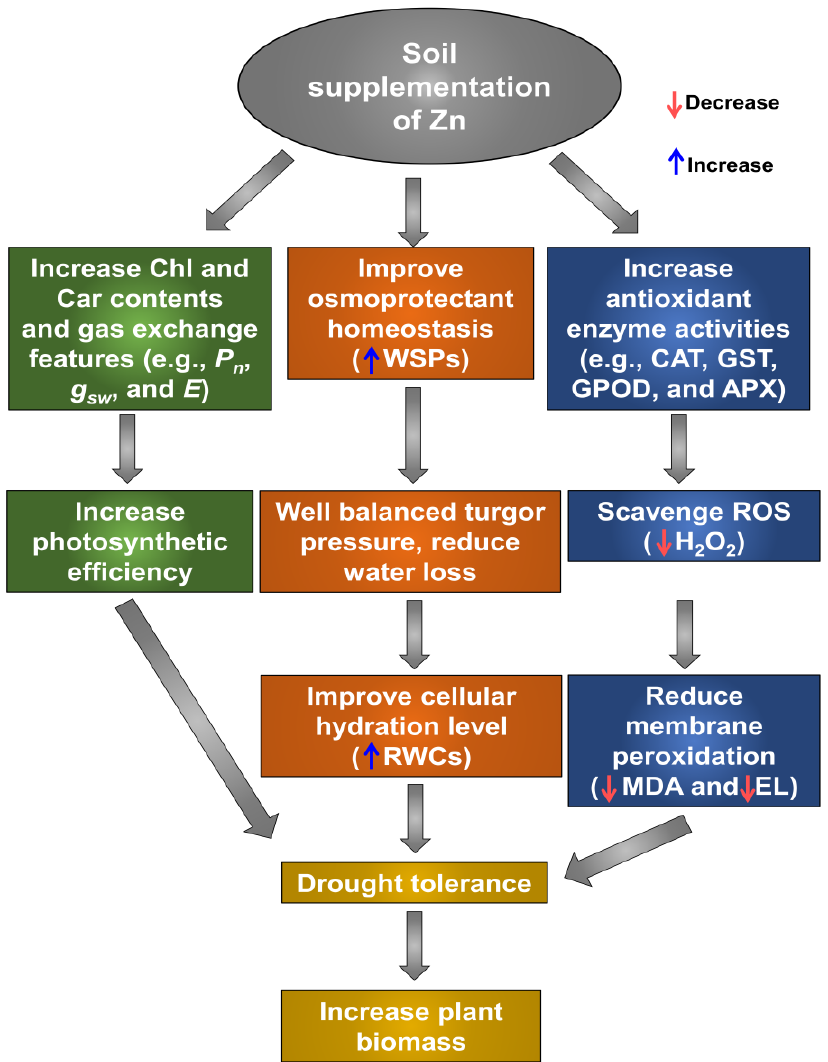
Figure 7. Function of zinc (Zn) in regulating cotton physiological and biochemical mechanisms to overcome drought-caused negative effects. Zn supplementation (either in the form of ZnSO 4 or ZnO) to drought-stressed cotton plants significantly decreased their growth penalty, partly by protecting photosynthetic pigments and improving gas exchange features, which finally enhanced the overall photosynthetic efficiency and growth performance. Zn addition also activated the antioxidant defense mechanism by increasing the activities of enzymatic antioxidants (e.g., CAT, GST, GPOD, and APX), which helped protect Zn-supplemented cotton plants against reactive oxygen species (ROS)-induced oxidative stress and membrane damage. Furthermore, through boosting water-soluble proteins (WSPs) content, Zn aided osmoprotection, which eventually helped preserve leaf water status for osmotic adjustment under water-scarce conditions. Blue arrow represents an upward trend, while red arrow denotes a declining trend. APX, ascorbate peroxidase; Cars, carotenoids; CAT, catalase; Chls, chlorophylls; E , transpiration rate; EL, electrolyte leakage; GST, glutathione S -transferase; GPOD, guaiacol peroxidase; g sw , stomatal conductance to H 2 O; H 2 O 2 , hydrogen peroxide; MDA, malondialdehyde; P n , net photosynthetic rate; RWCs, relative water contents; Zn, zinc.